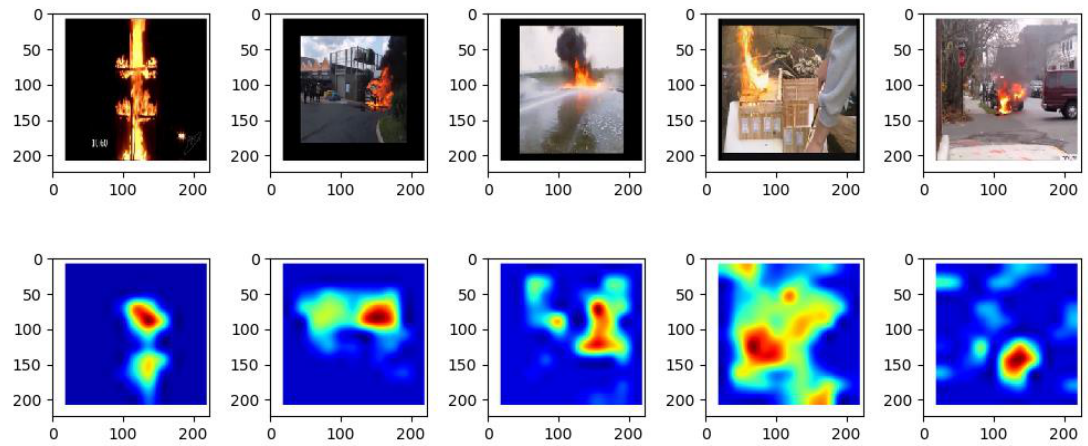
Figure 6. FireNet model localizes the fire area using class activation maps (CAMs), which highlight areas of the image that are most important for making the areas of the image that are most important for making predictions.